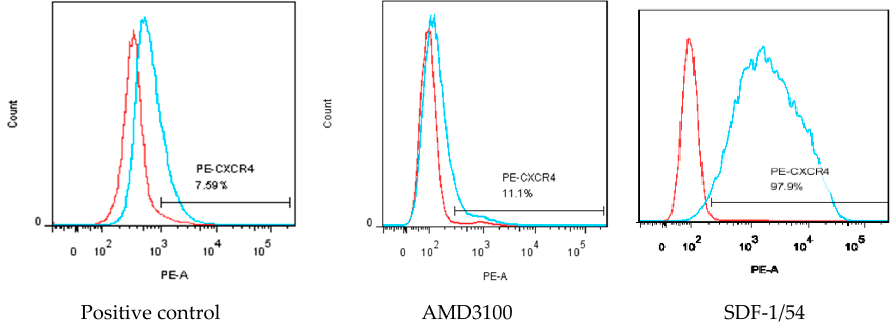
Figure 7. Capability of SDF-1 / 54 inducing CXCR4 internalization. MT-2 cells were treated with AMD3100 and SDF-1 / 54 for 2 h at 50 nM and CXCR4 on the cell surface was detected indirectly by